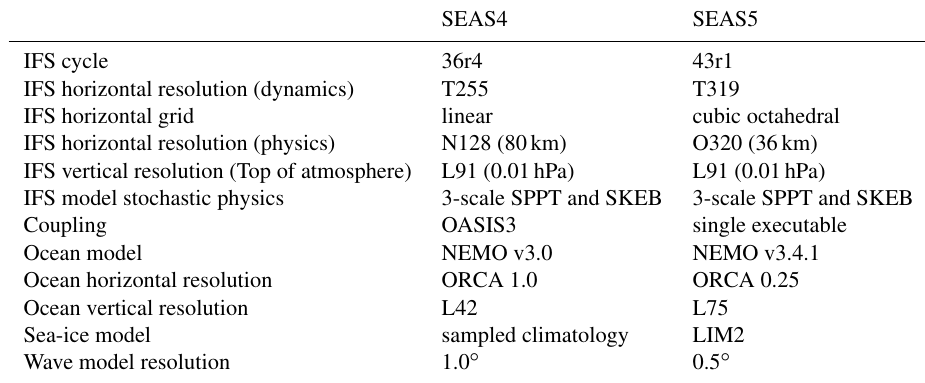
Table 1. Table comparing the configuration of SEAS4 and SEAS5. Abbreviations are defined in the